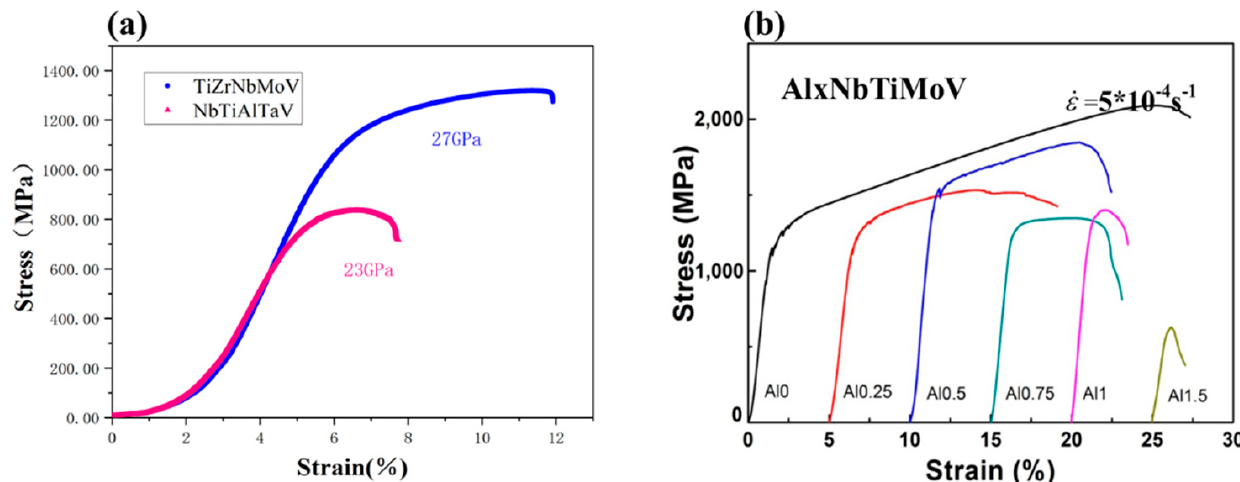
Figure 5. ( a ) Stress-strain curves of TiZrNbMoV and NbTiAlTaV alloys tested at a compression rate of 10 − 4 s − 1 . ( b ) Stress-strain curves of Al x NbTiMoV alloys, data from [30].